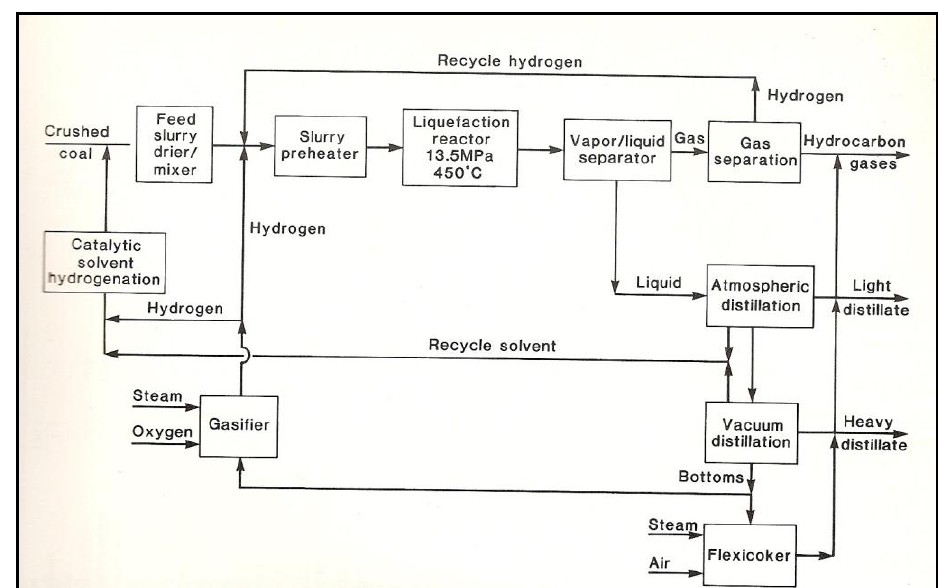
Figure 5. Exxon donor solvent process .